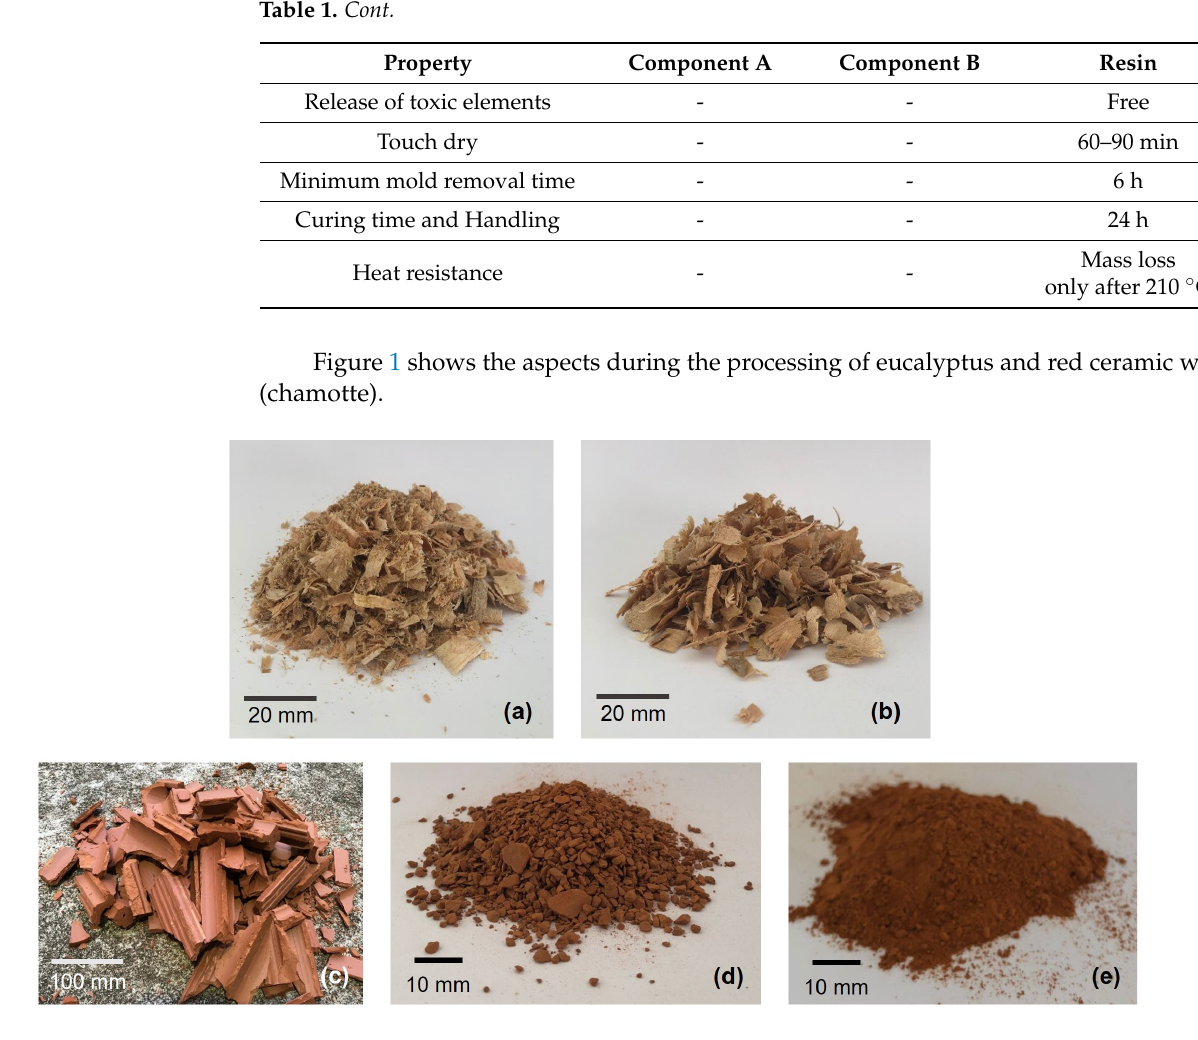
Figure 1. Aspect of raw materials during processing: ( a ) sawdust residue as received, ( b ) retained on sieve of 10 mesh, ( c ) chamote as received, ( d ) chamotte comminuted, and ( e ) chamotte after milling and sieving in 270 mesh.